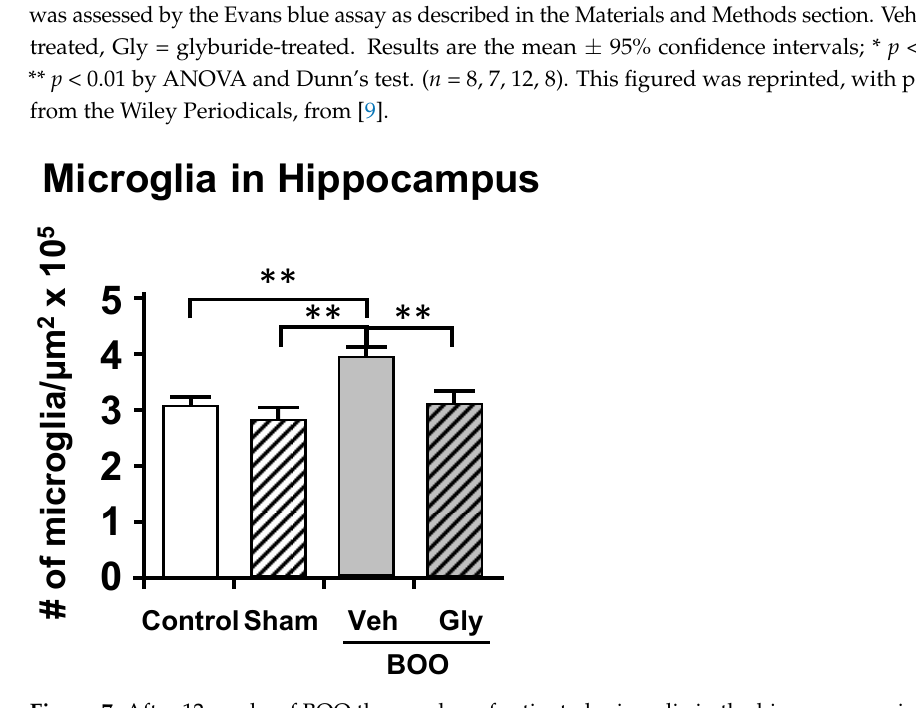
Figure 7. After 12 weeks of BOO the number of activated microglia in the hippocampus is increased and this increase was blocked by glyburide treatment. Activated microglia in 10 µ m sections of brain were stained for IbA1/AIF1 and then visualized and quantitated. The results are presented as the density of activated microglia per µ m 2 . Veh = vehicle-treated, Gly = glyburide-treated. Results are the mean ± 95% confidence intervals; ** p < 0.01 by ANOVA and Dunn’s test. ( n = 7, 6, 8, 7). This figured was reprinted, with permission from the Wiley Periodicals, from [9].